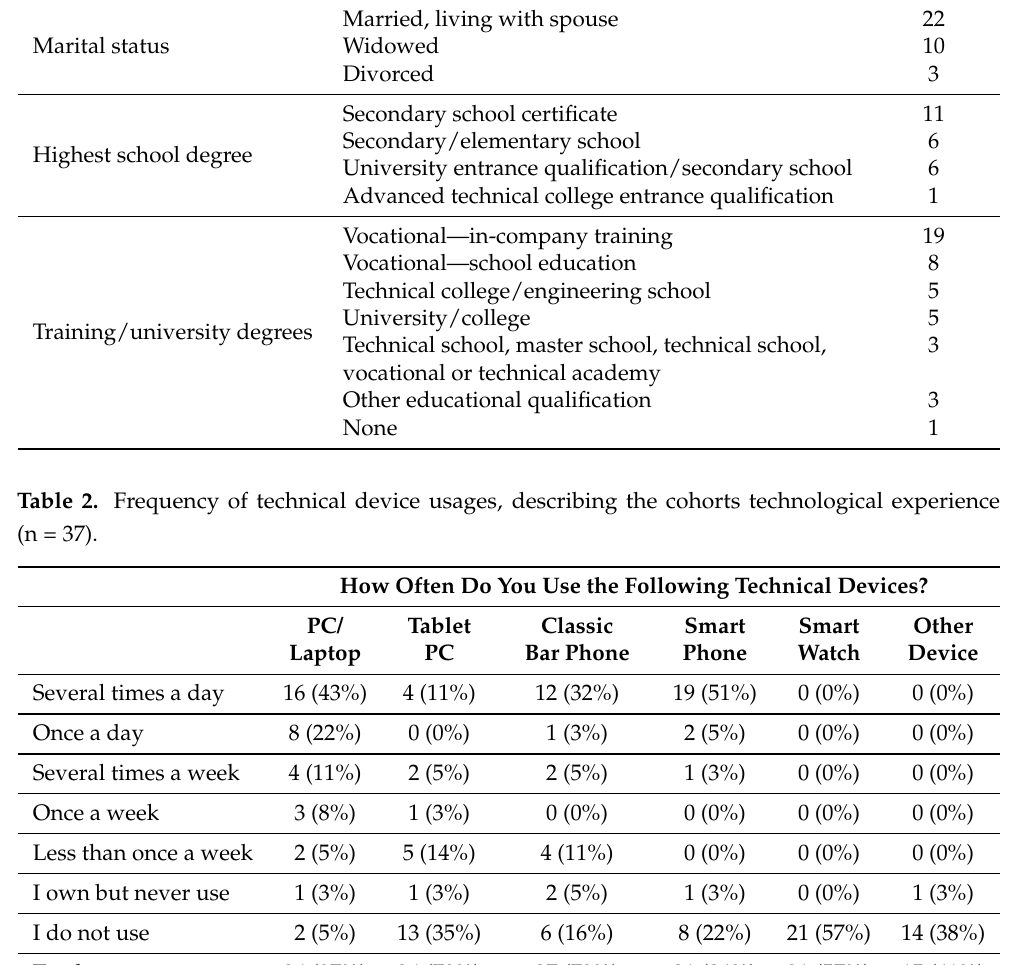
Table 1. Additional sociodemographic parameters (frequency as n), ordered in accordance to occur- rence; regarding training/university degrees, multiselection was supported (n = 37). Parameter Item Occurence Married, living with spouse